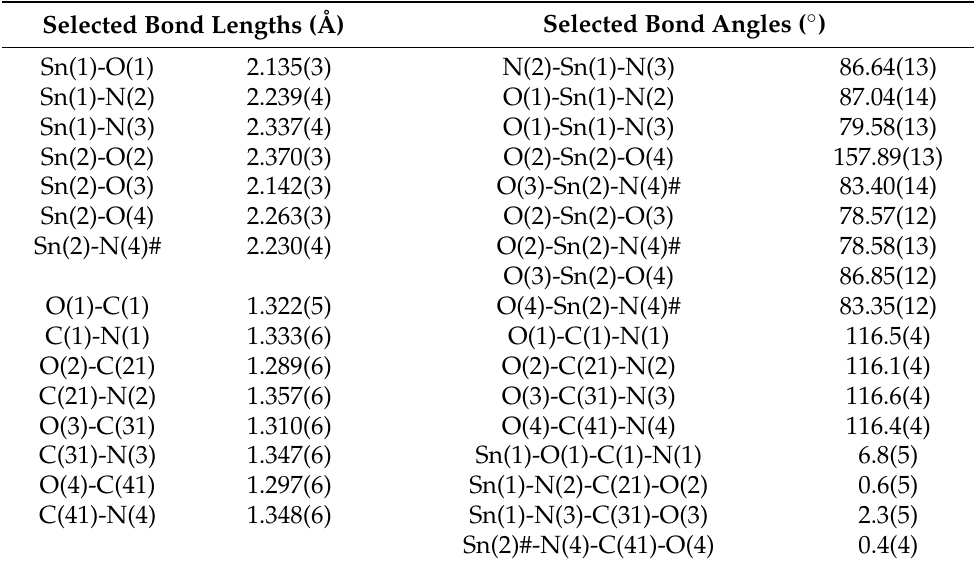
Table 3. Selected bond lengths (Å) and bond angles ( ◦ ) for complex 2 . Symmetry-generated atoms are marked with